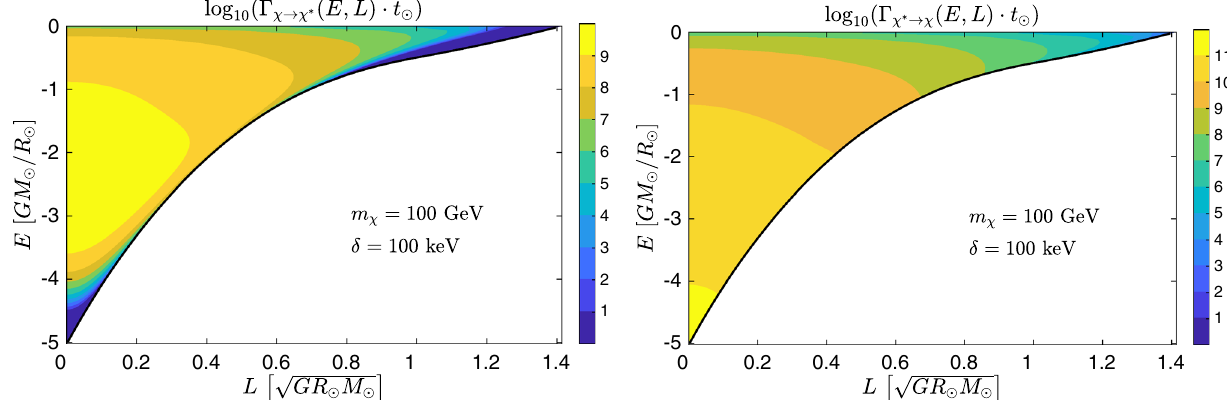
Fig. 3 The base 10 logarithm of the product of the total scattering rate and the solar lifetime t (cid:9) in the E - L plane. We fix m χ = 100 GeV and δ = 100 keV. Left panel: Endothermic scattering. Right panel: Exothermic